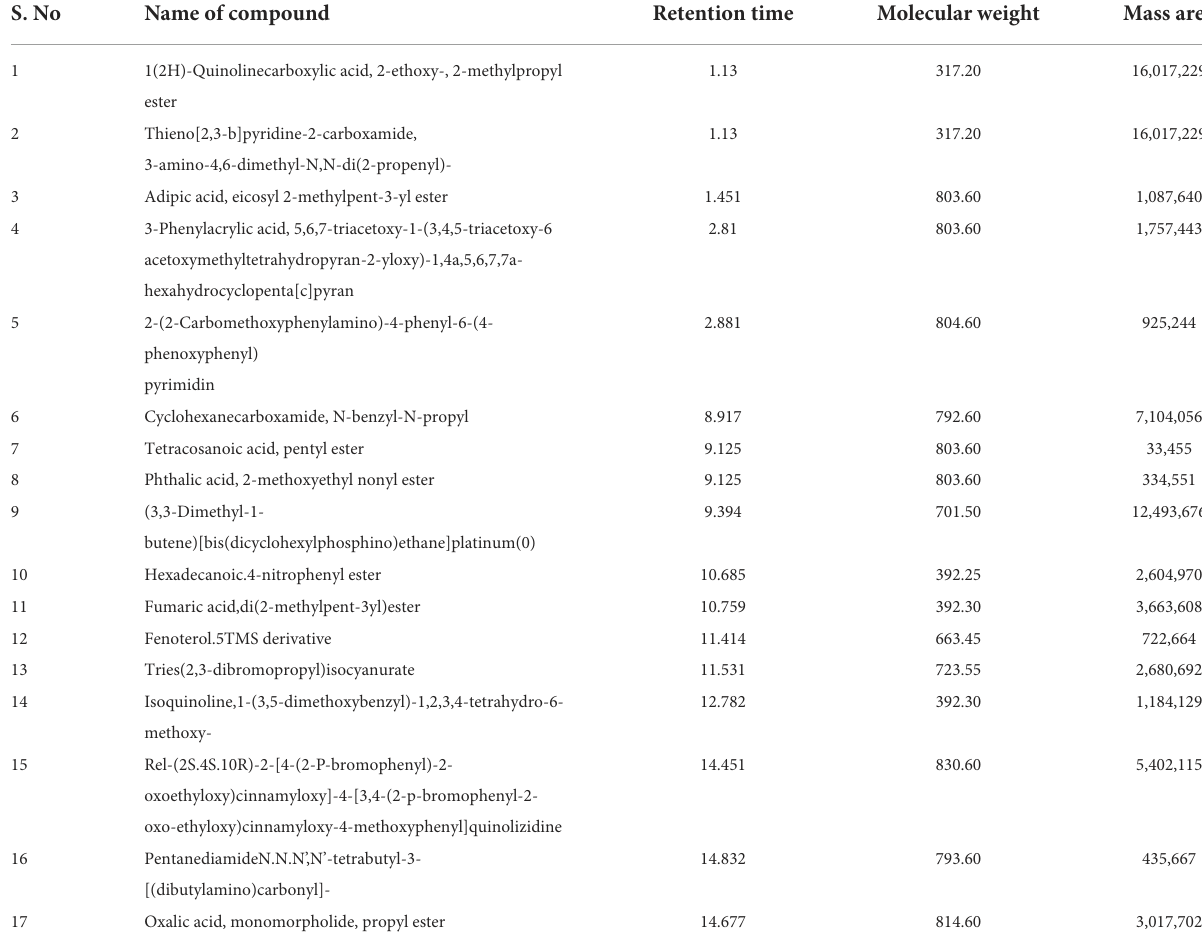
TABLE 5 Identified compounds in B. aurea flower extract by the LCMS method. S.